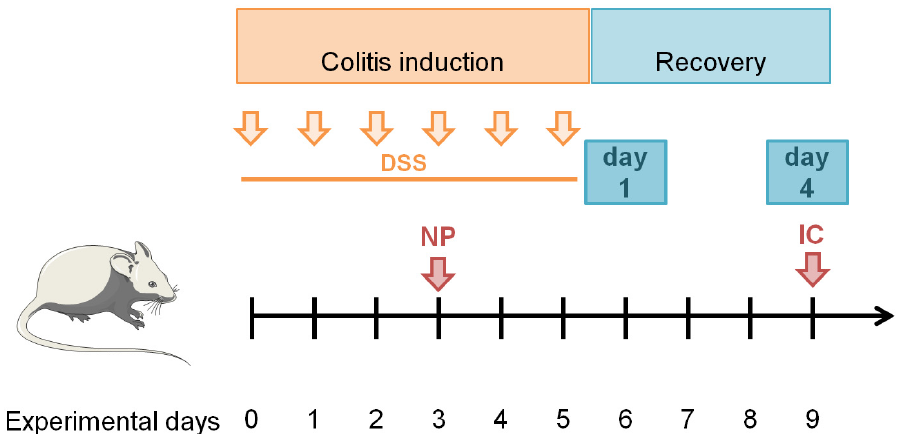
Figure 2. Timeline of in vivo experiments. NP—nanoparticles, IC—imaging of cathepsin activity in organs, DSS—dextran sulfate sodium (colitis inducer).